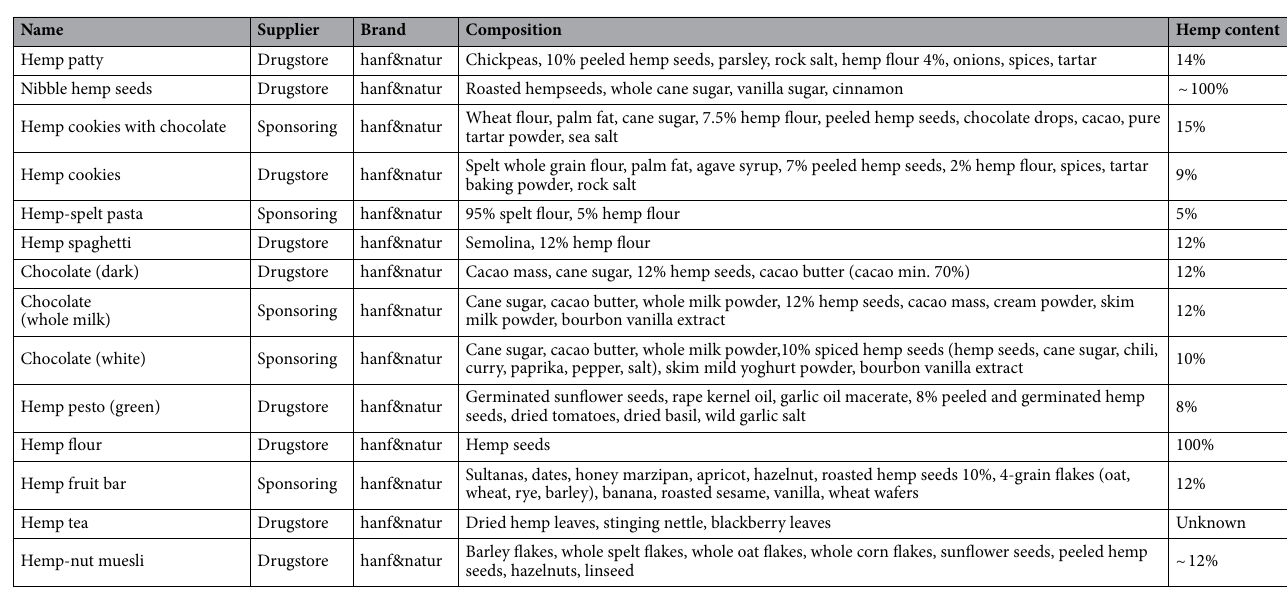
Table 2. Analysed food